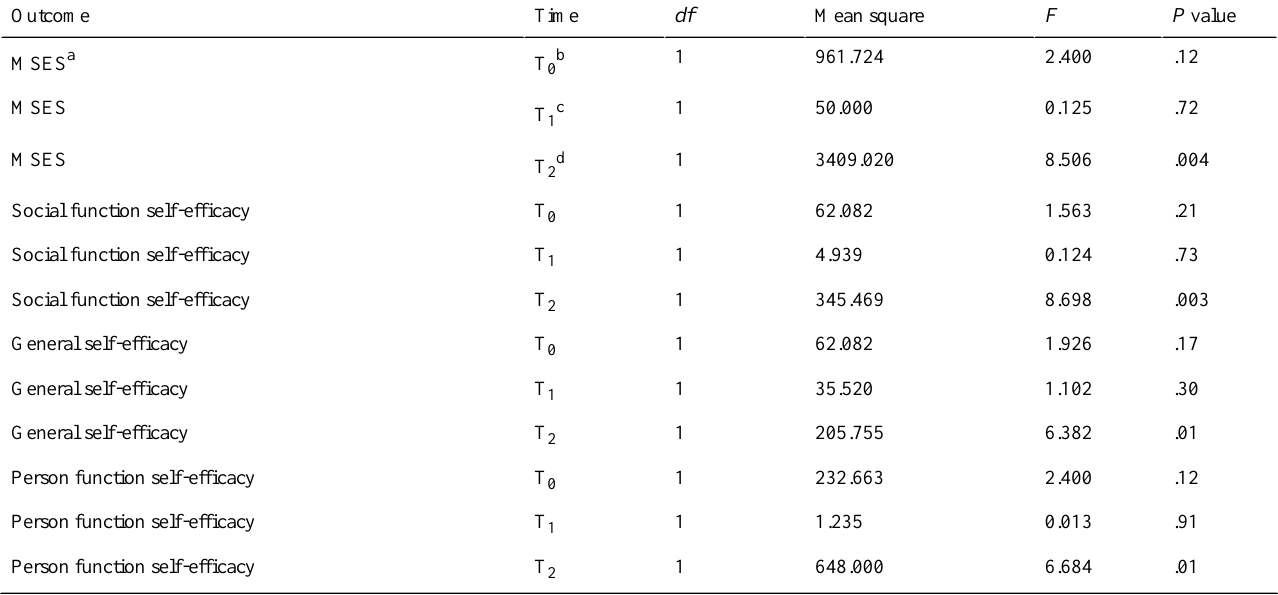
Table 5. Simple effect analysis results of the Moorong Self-Efficacy Scale between the study and control groups.